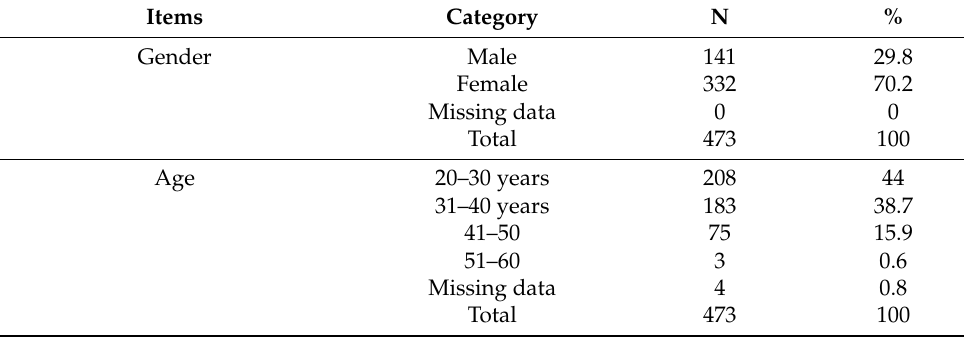
Table 2. Demographic profile of respondents (n =